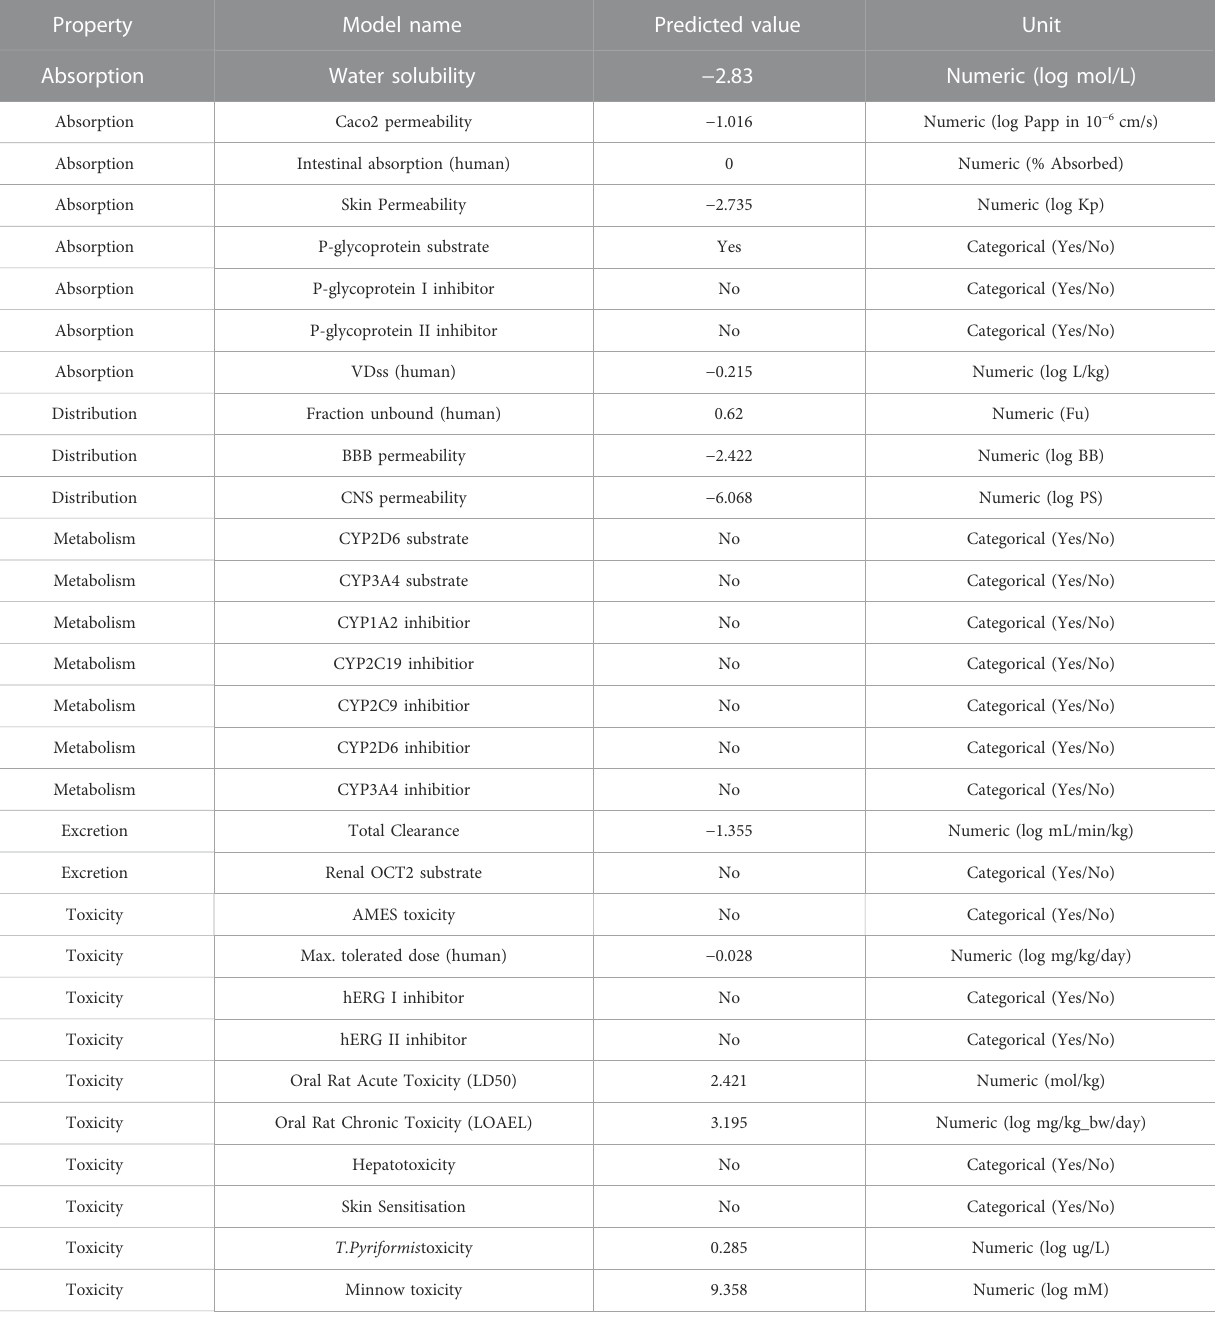
TABLE 5 Depiction of ADMET results for